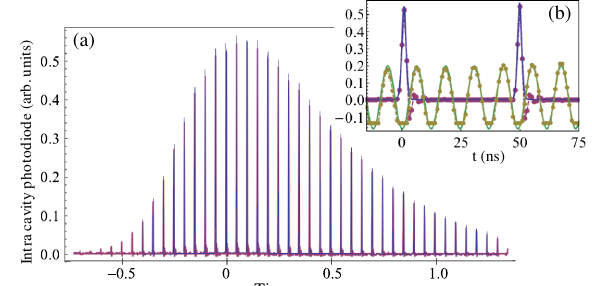
FIG. 2. (a) Sample scope trace of the pulse train as measured by the photodiode (red) and analytical fit used in the analysis (blue). In the inset (b) the 14th and 15th pulse of pulse train (red) and relative fit (blue) yield a cavity period of 49.02 ns. The reference signal from the photodiode on the laser master oscillator (yellow) and its sinusoidal fit (green) are also shown. The period of the laser oscillator signal (12.2549 ns) is exactly 1 = 4 of the roundtrip of the IFEL cavity. The x-axis is shifted so that zero corresponds to the peak of